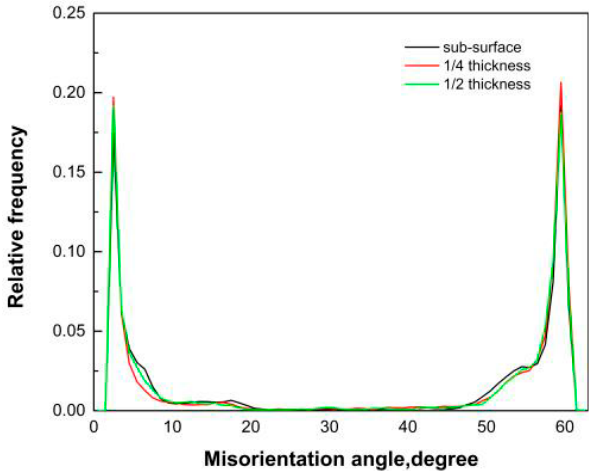
Figure 3. Relative frequency of misorientation angle obtained by EBSD.